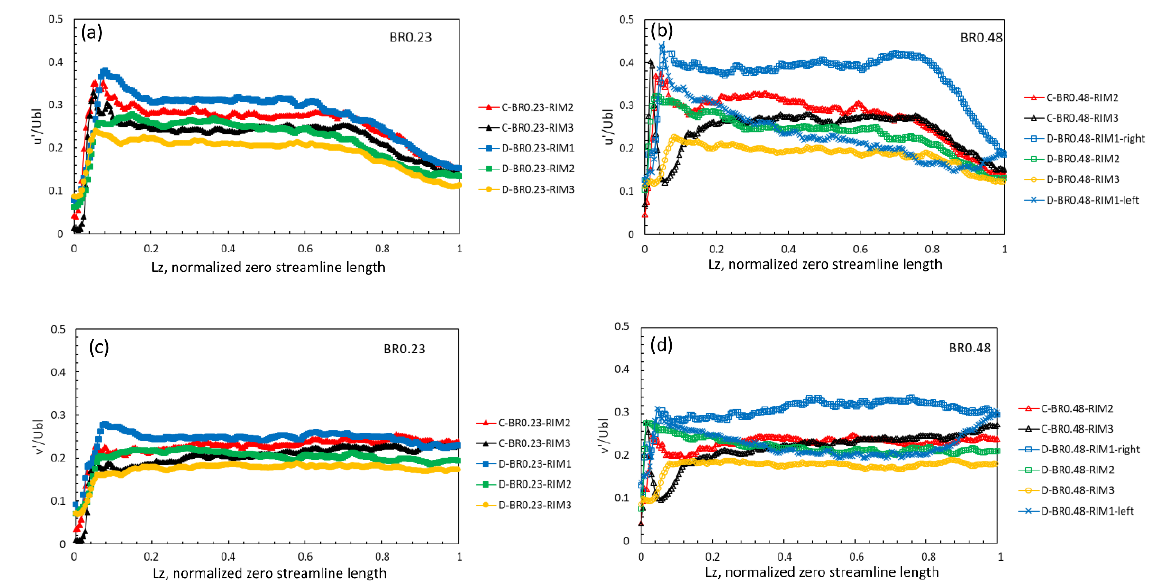
Figure 8. Zero streamline distributions of the axial ( a , b ) and radial ( c , d ) velocity fluctuations, for (i) BR0.23 and (ii) BR0.48 baffles.